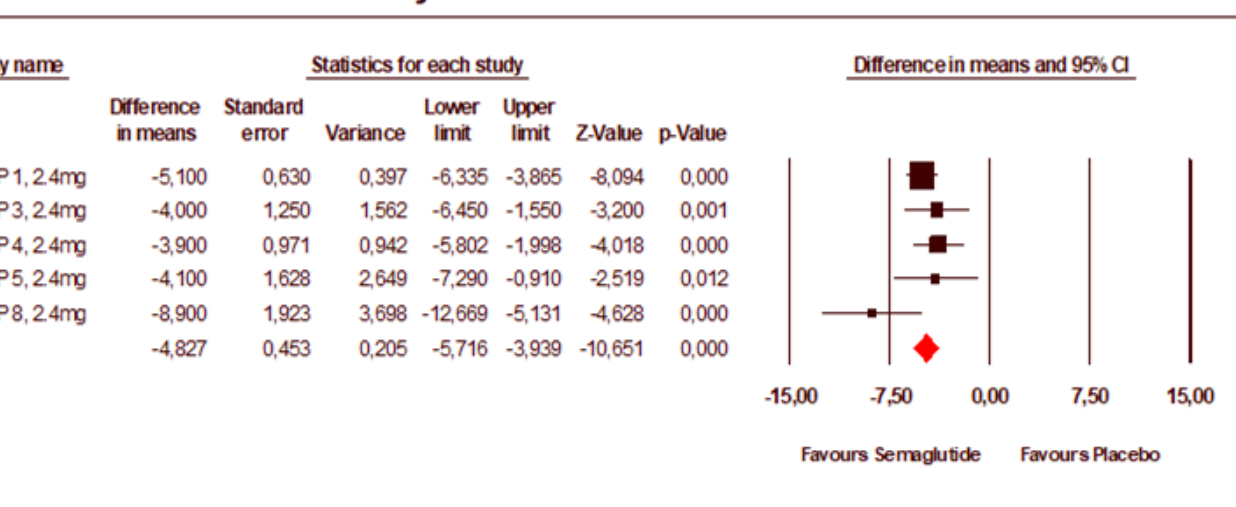
Figure 4. Forest plot of the phase 3 studies of semaglutide 2.4 mg vs. placebo showing the pooled weighted mean difference for SBP (random effects model).